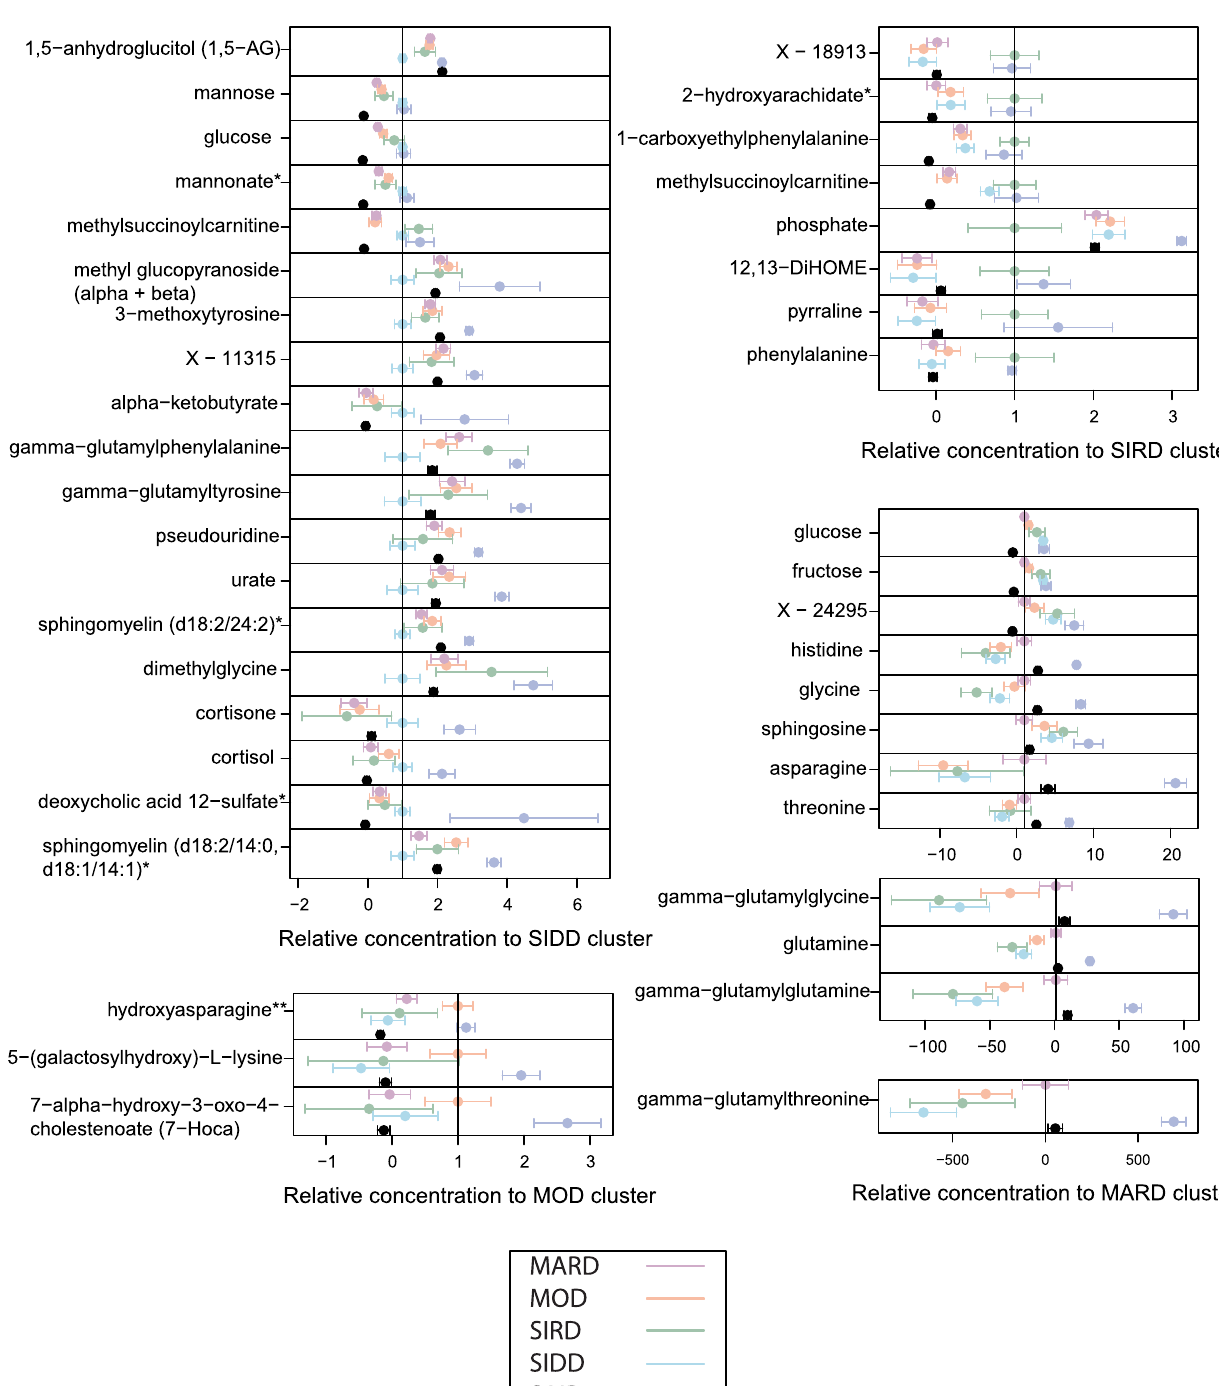
Fig. 5 | Metabolites that distinguish individual diabetes subtypes ( N =420 individuals). The dotsand barsrepresent the meanmetabolite valuesand the95% con fi dence intervals of the means for metabolites that are different in one of the four T2D subtypes compared to all others. Values are normalized by the mean of